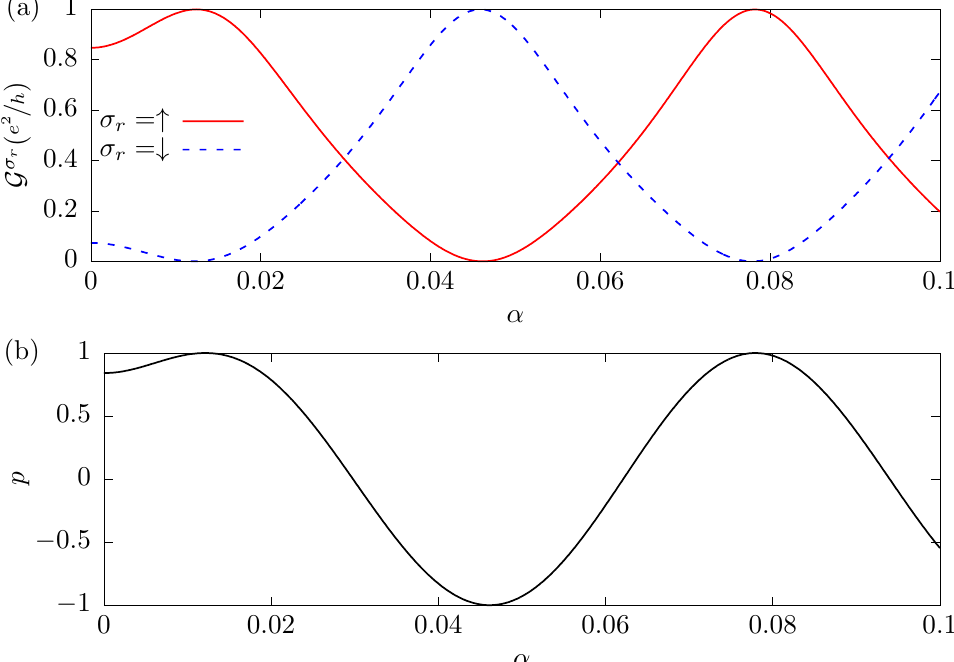
σ r , panel ( a ), and the spin polarization of the current p , panel ( b ), Figure 4. The conductance G as a function of the Rashba SOC intensity α . The distance between contacts is R = 100 a and the Dresselhaus SOC parameter is β = 10 − 2 t . The Fermi level is given by Equation (12), (cid:101) F = σ r is completely spin-polarized. 9.422 10 − 2 t , and when α satisfies Equation (13), × G The electronic current injected into the metallic conductor J σ r ( V ) is obtained from the σ r by Equation (7). Its behavior, as a function of the applied potential V , is conductance G shown in Figure 5. The parameters that define the system are taken to be the same as those of Figure 4, for the SOC intensities discussed above, for which the conductance is completely spin-up. As in Figure 4, the Fermi level (cid:101) F is fixed at the positive value where the first spin-down conductance minimum occurs, according to Equation (12), (cid:101) F = 9.422 10 − 2 t ×